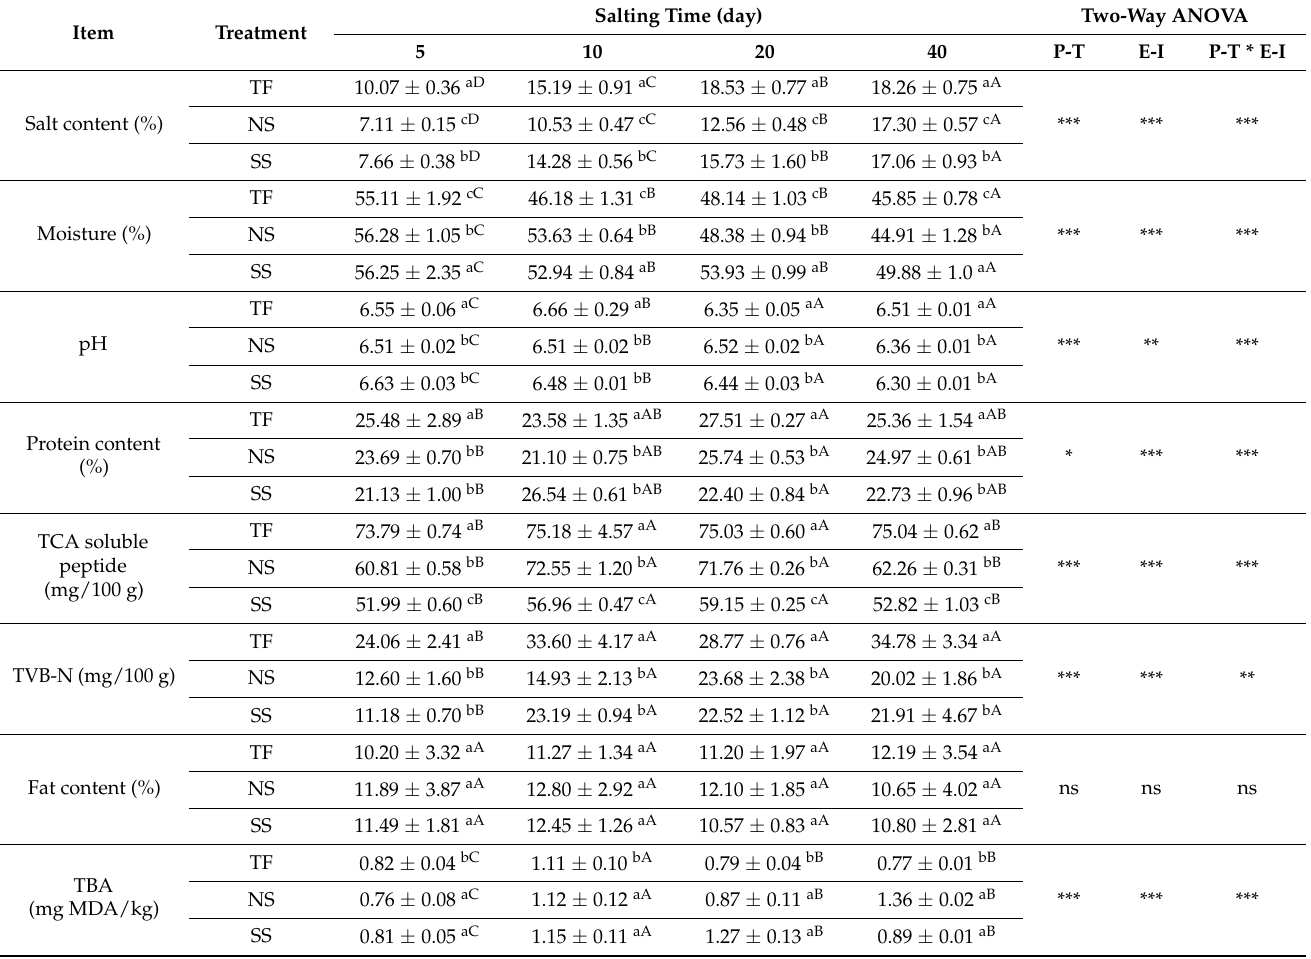
Table A3. Physicochemical properties of salted herrings analyzed with two-way